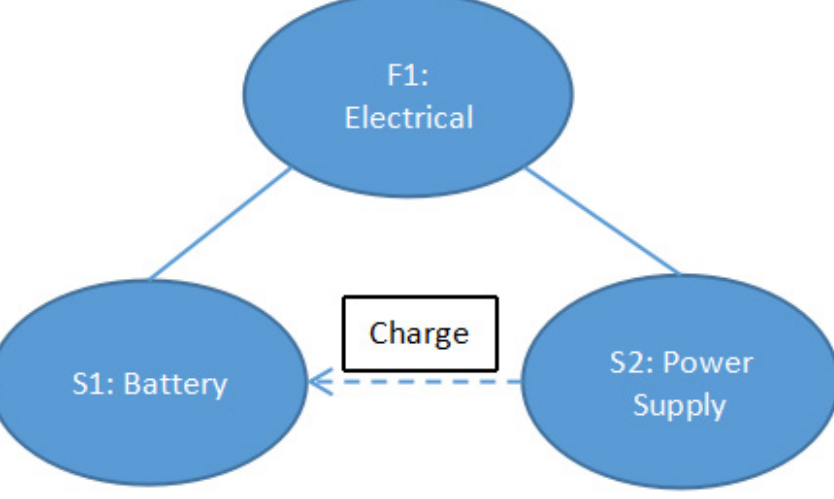
Figure 6. Su-field model for constraint 2.